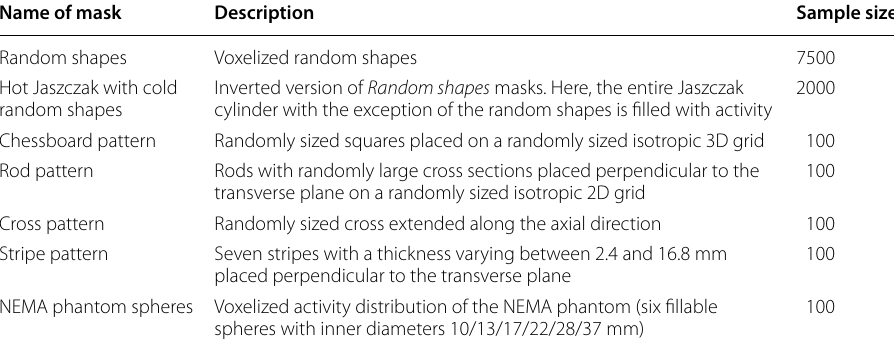
Before inclusion in the mask, all objects were randomly rotated in the three spatial dimensions (exception: NEMA phantom, random two‑dimensional rotation in the transversal